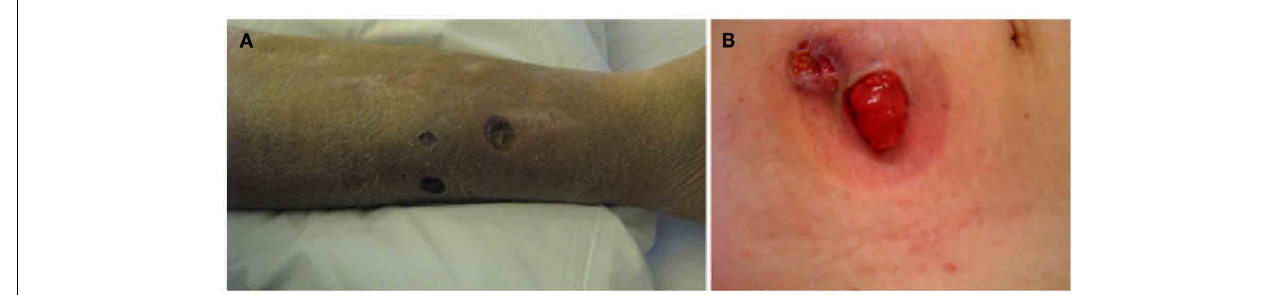
FIGURE 4 | Pyoderma gangrenosum can start as small pustules that as they progress form larger and deeper ulcers. Classically, the borders of the lesions are mucopurulent and purple. Example of pyoderma gangrenosum lesion involving the leg (A) and parastoma (B)